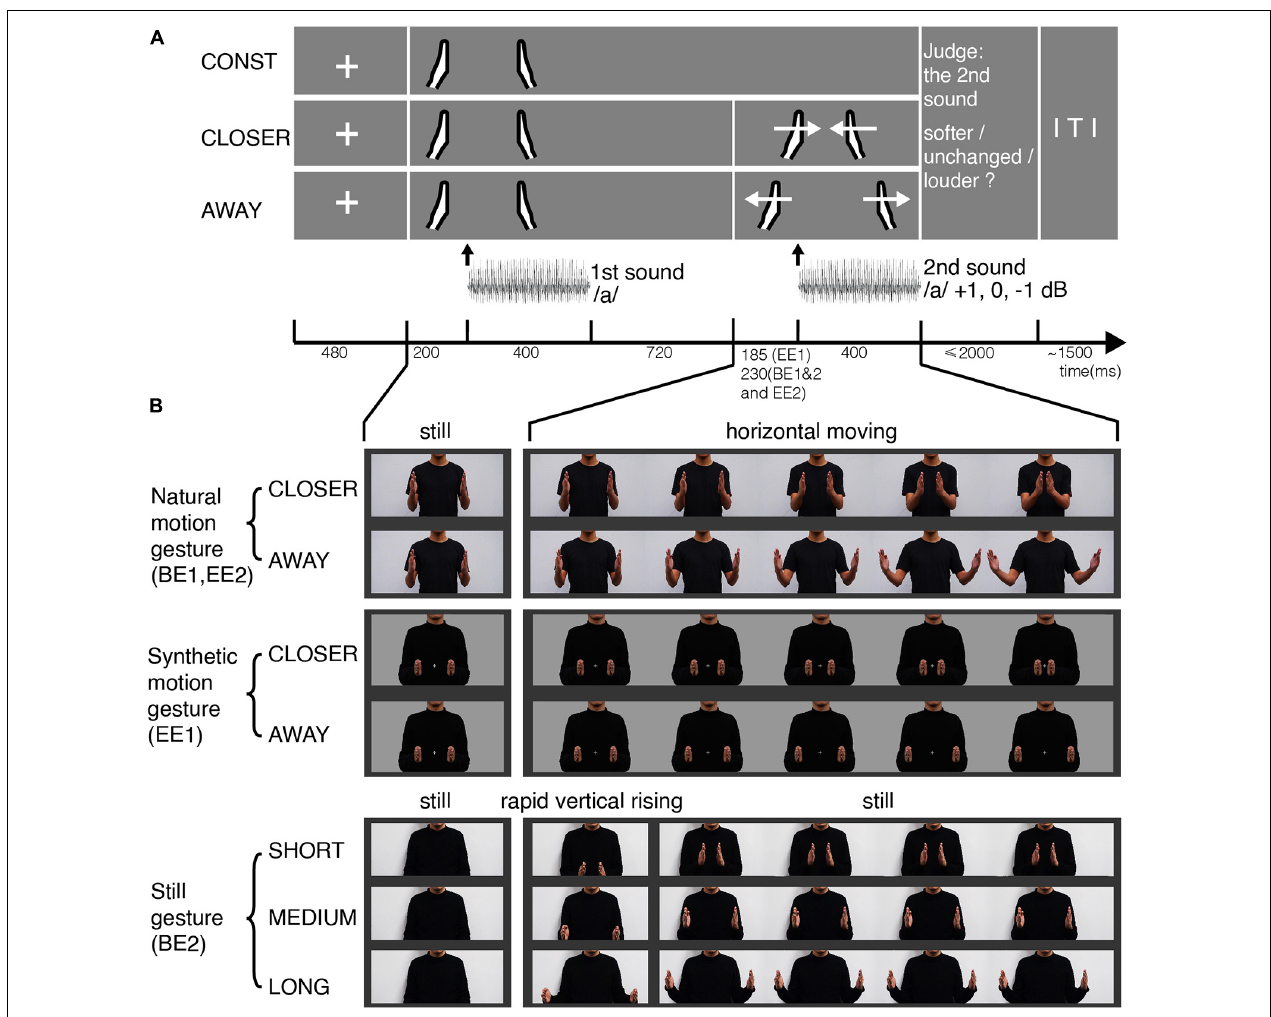
FIGURE 1 | Experimental procedures and stimuli for the four experiments. (A) Experimental procedures in BE1, EE1, and EE2 (not in BE2). Each row depicts one condition in which the gestures vary. Participants first saw the still image of two hands in the middle position relative to the body and heard the vowel/a/. Then they either saw the motional gestures (CLOSER, AWAY) or the same still image (CONST). Meanwhile, they heard the same vowel/a/that either remained unchanged or increased 1 dB or decreased 1 dB from the first-time presentation. Participants performed a loudness judgment task. (B) Frames of gesture video clips. A male torso was shown from waist to chin in the middle of the screen. The hands always started from the middle position as a still image, followed by moving horizontally either toward each other (CLOSER) or away (AWAY). In BE1 and EE2, we used gestures with natural motion (the first row), recorded using a video camera and edited in Adobe Premiere. In EE1, we used gestures with computer-synthetic motion (the second row), controlled by a set of displacement functions (three periods: constant acceleration, uniform motion, constant deceleration). In BE2, we used still images of gestures with three different distances (the last row). The gestures appeared from the initial image of the body with a rapid vertical rising in two video frames and remained still until the end of the second sound.